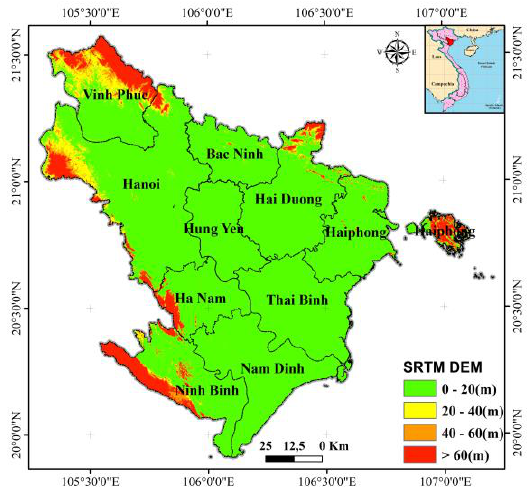
Figure 2. Map of 10 provinces in the RRD & topography from